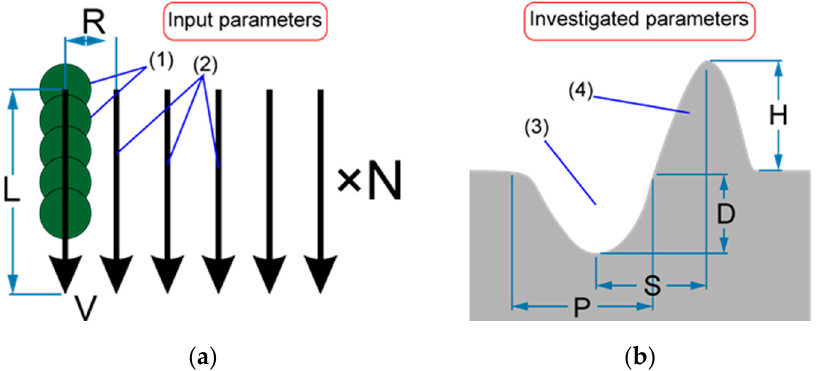
Figure 3. ( a ) Diagram of laser beam movement with input parameters: R—the distance between processing lines, L—line length, V—beam travel speed on the surface, N number of repetitions. ( b ) Investigated parameters of the cross-section of the relief: P—groove width at the surface, S—horizontal distance between the point of the greatest groove depth and the point of the most significant height of the deposited bead D—groove depth H—height of the deposited bead. ( 1 )—pulses of laser radiation, ( 2 )—lines along which the surface is irradiated, ( 3 )—groove, ( 4 )—a bead of melt.